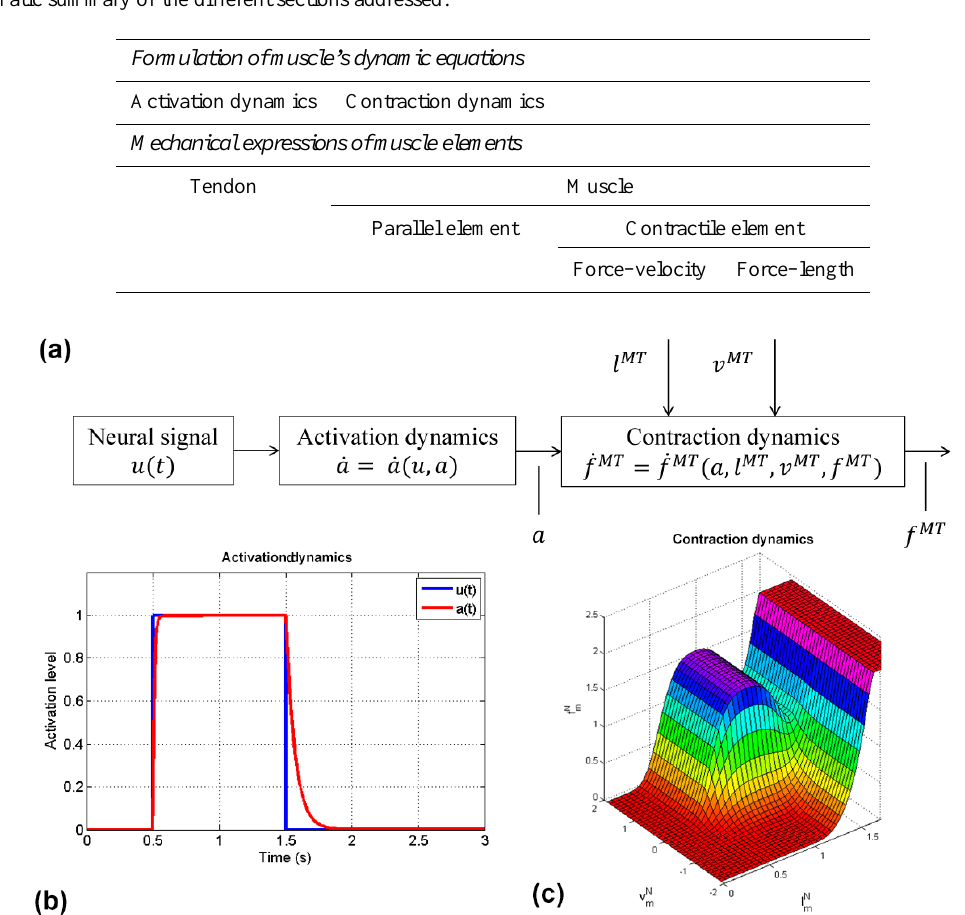
Table 1. Schematic summary of the different sections addressed.